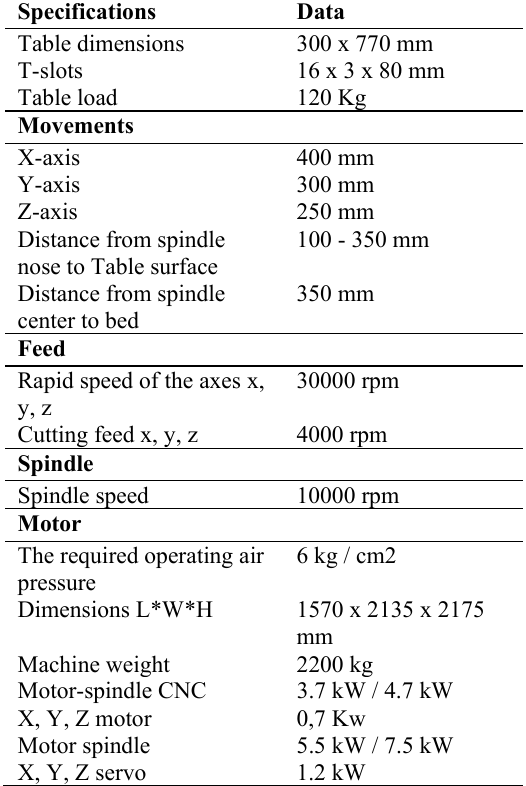
Description of the specifications of the CNC machine (Knuth Rapimill 700)